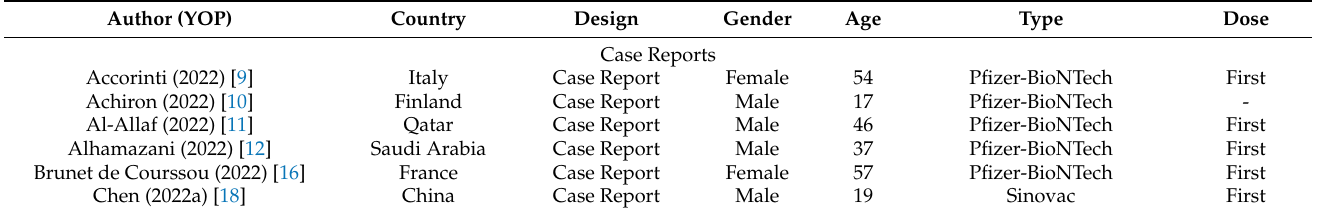
Table 1. The baseline characteristics of studies reporting COVID-19 vaccine-associated uveitis cases.